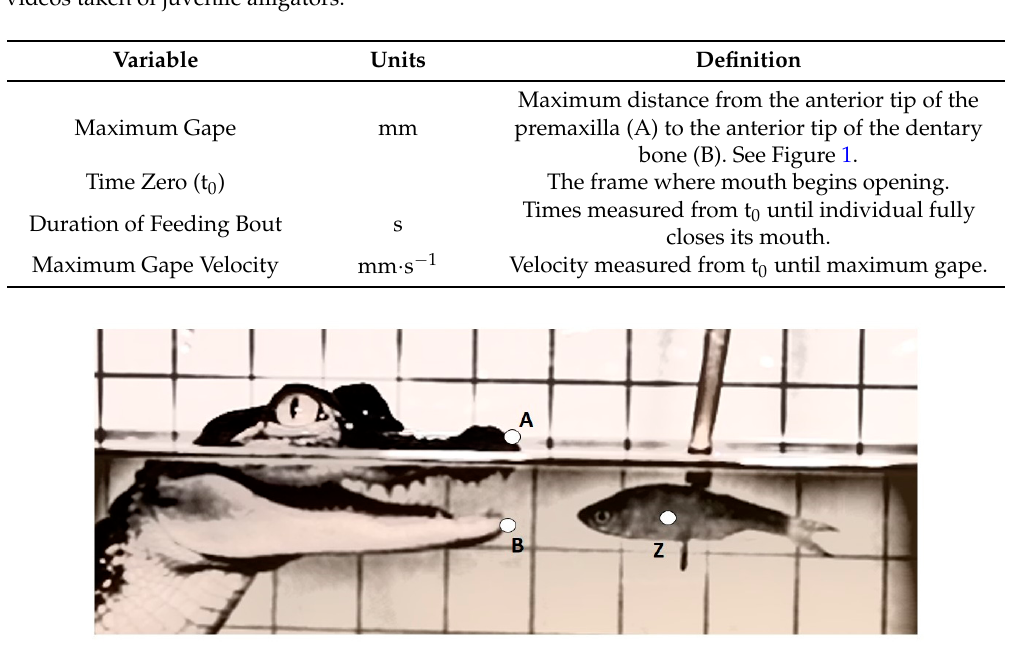
Figure 1. Diagram of A. mississippiensis portraying landmarks used to measure linear excursions during an underwater feeding event. A: anterior tip of the premaxilla; B: anterior tip of the